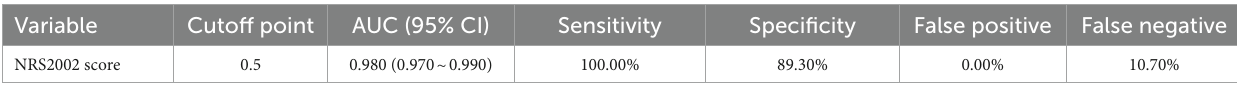
TABLE 6 The performance of various methods for distinguishing between severe cases and non-severe cases ( n = 1,228).